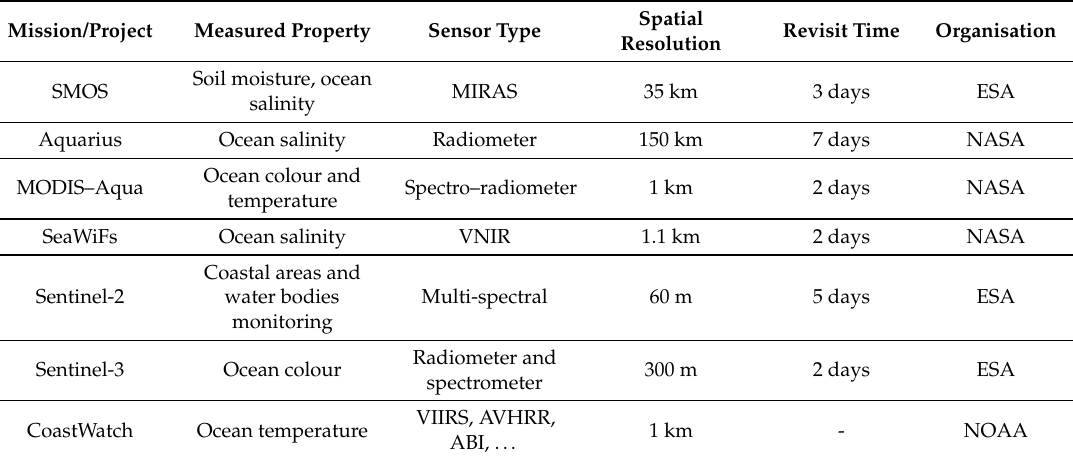
Table 1. Summary of satellite missions and projects used for SST and/or SSS